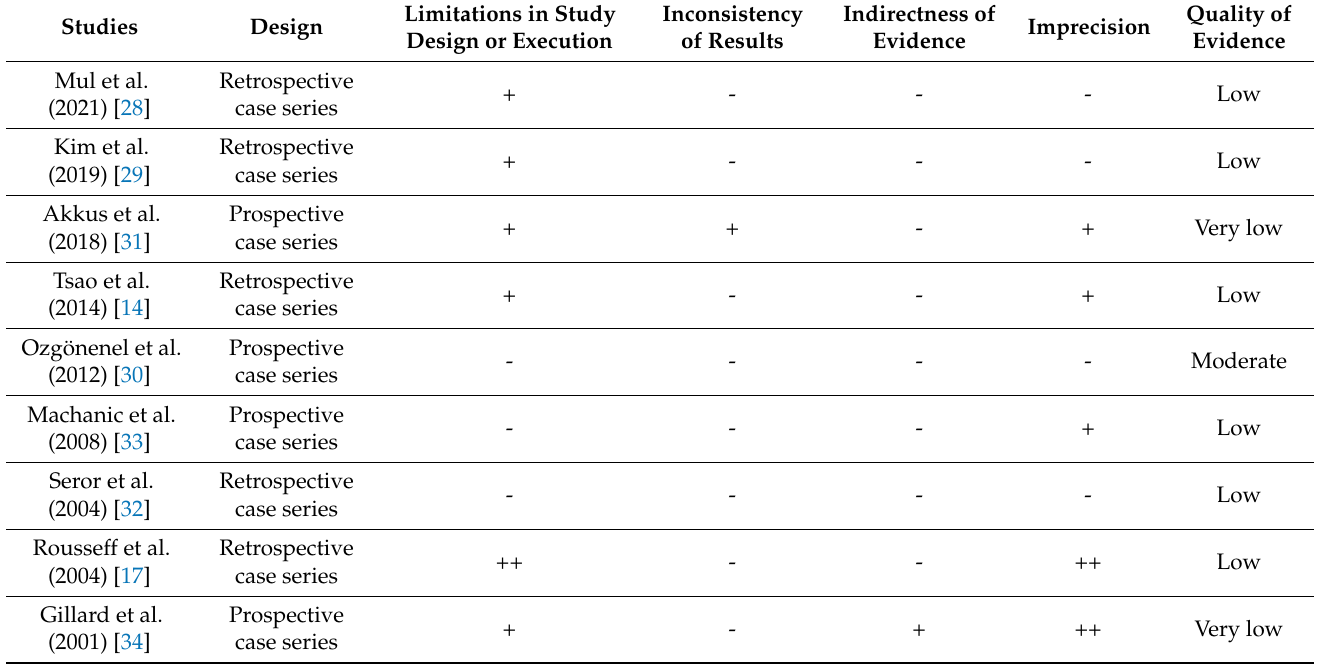
Table 2. Evaluation of the level of evidence using the GRADE